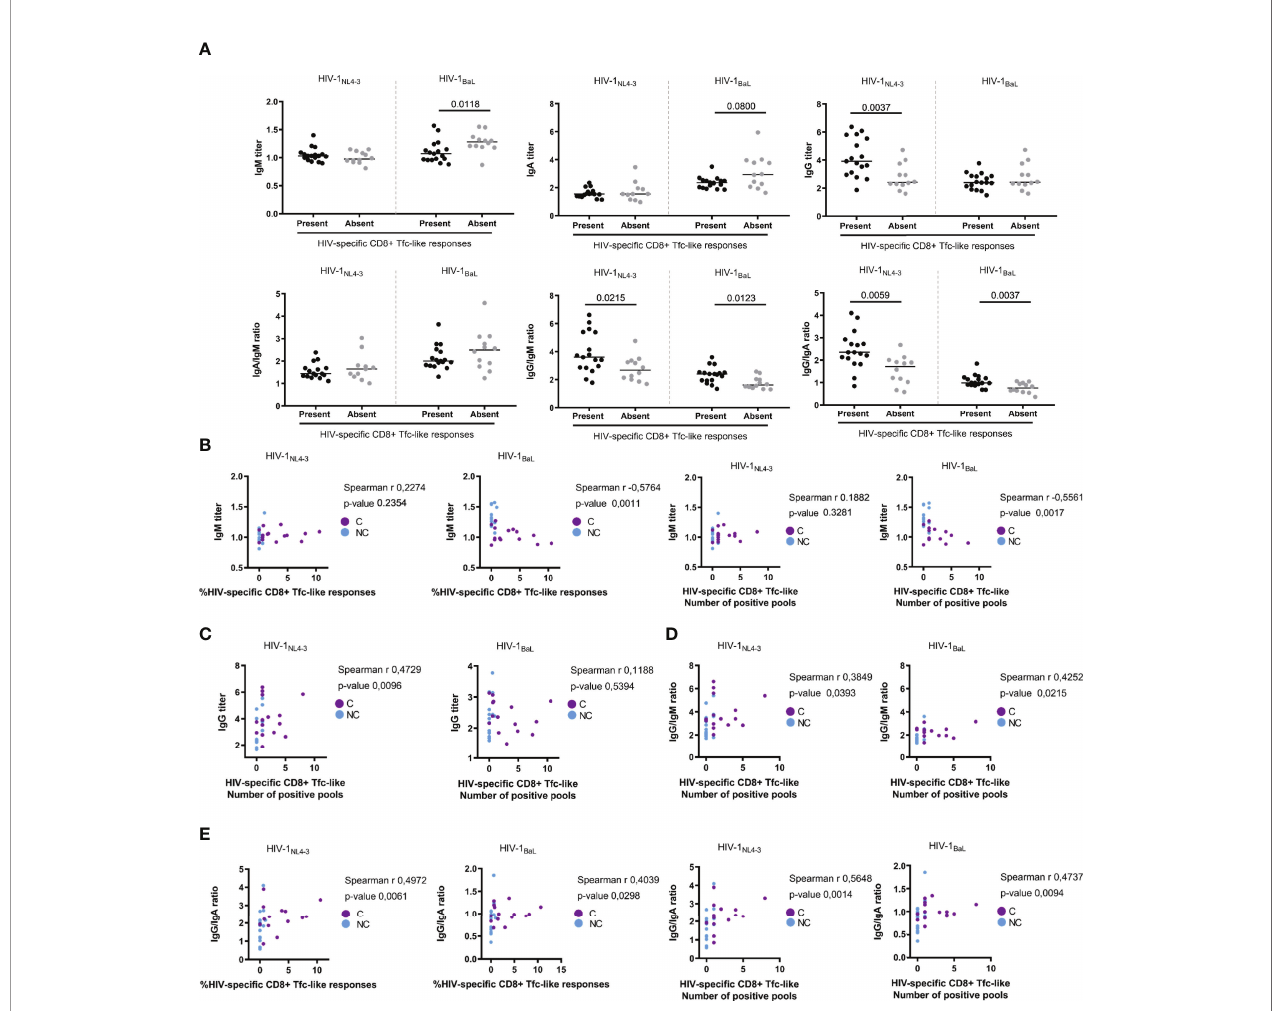
FIGURE 8 | Link between HIV-speci fi c CDS+ Tfc-like responses and humoral responses. (A) Samples were strati fi ed by the presence (n=17) or the absence (n=13) of HIV-speci fi c CD8+ Tfc-like responses and titers of lgA, lgG and lgM were compared, as well as the lgA/IgM, lgG/IgM and lgG/IgA ratios. (B) Correlation between anti-HIV-1NL4_3 (left) and HIV-lsaL (right) lgM titers with CD8+ Tfc-like magnitude (left) and breadth (right). (C) Correlation between anti-HIV-1NL4_3 (left) and HIV- lsaL (right) lgG titers with CD8+ Tfc-like breadth. (D) Correlation between anti-HIV-1NL4.3 (left) and HIV-lsaL (right) lgG/IgM ratio with CD8+ Tfc-like breadth. (E) Correlation between anti-HIV-1NL4_3 (left) and HIV·lsaL (right) lgG/IgA ratios with CD8+ Tfc-like magnitude (left) and breadth (right). Statistical signi fi cance of the comparison were performed by non-parametrical Mann-Whitney test while non-parametric Spearman r correlations were